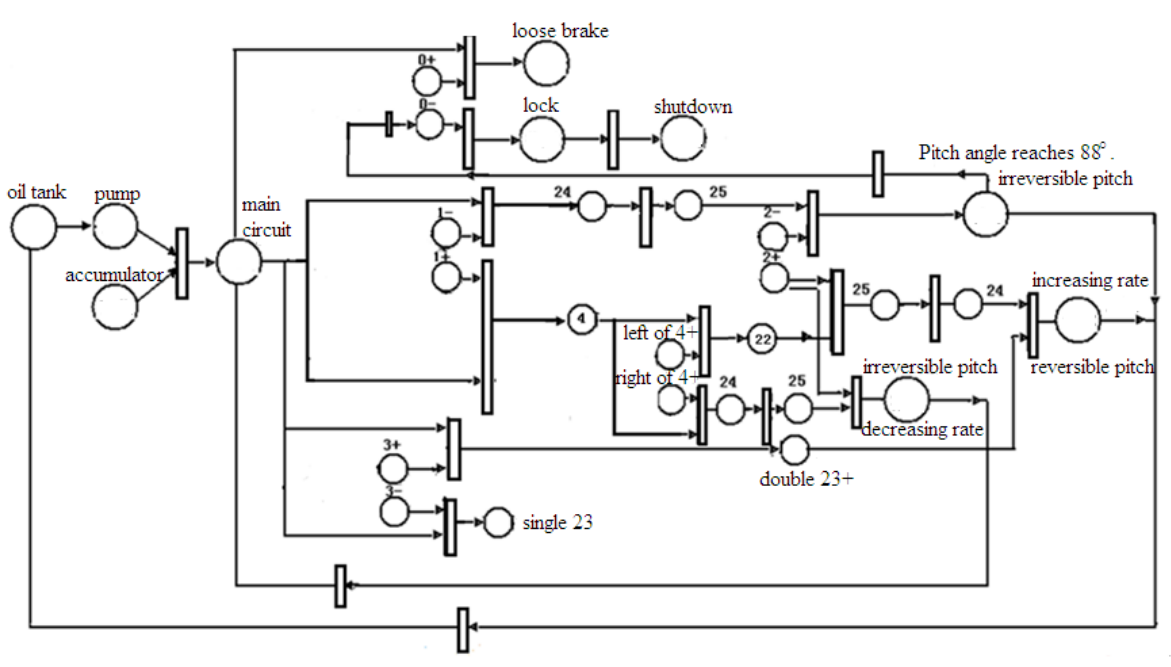
Figure 4. Basic Petri net of a variable pitch system.